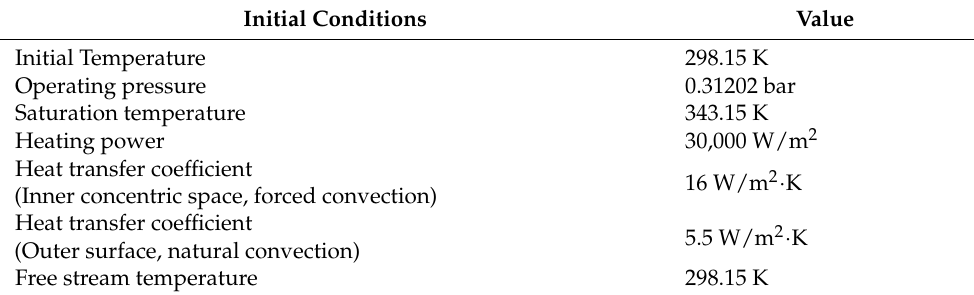
Table 3. Boundary